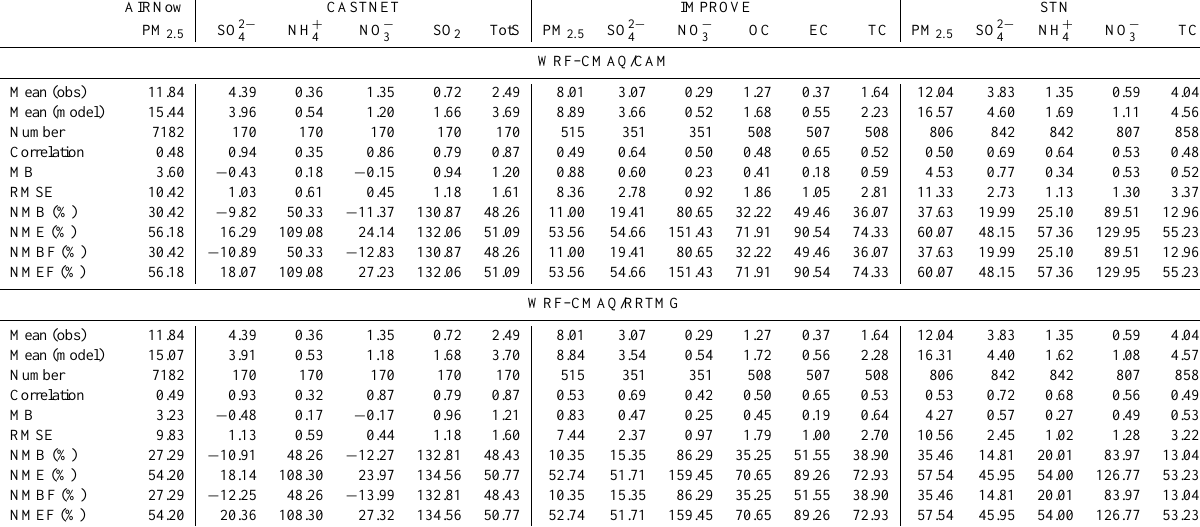
Table 7a. The same as Table 5a, but for September of 2006 for EUS. AIRNow